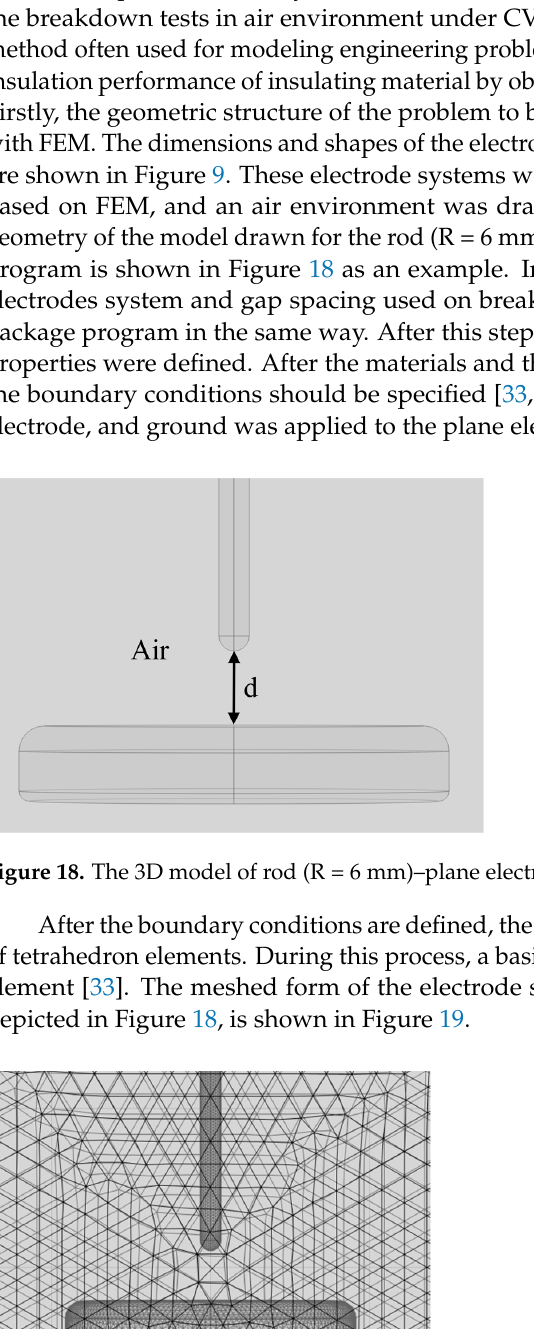
Figure 17. Variation of 50% breakdown voltage for needle–plane electrode system according to dif- ferent +DC and − DC values: ( a ) +LI; ( b ) − LI.